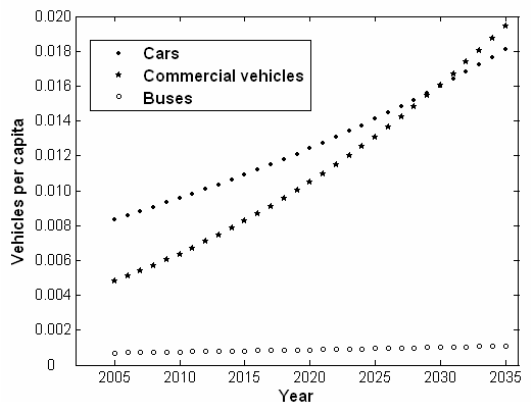
Fig 10. Projected vehicle ownership values